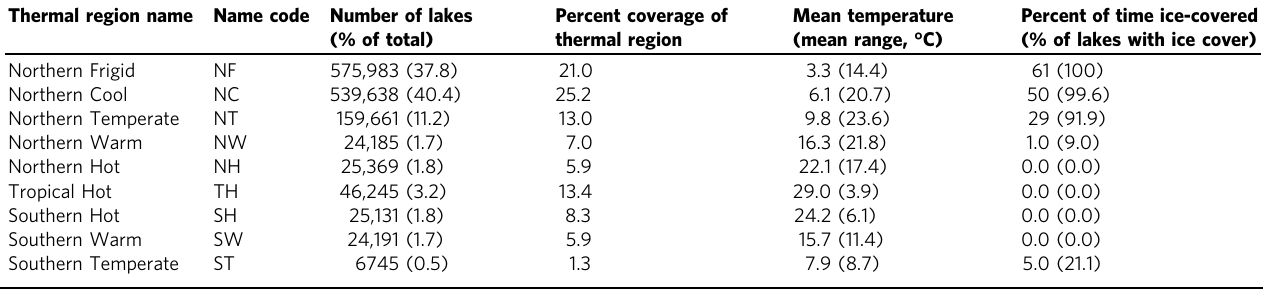
Table 1 Details of the nine thermal regions. The number of lakes refers to the HydroLAKES database and the historic period. Thermal region name Name code Number of lakes (% of